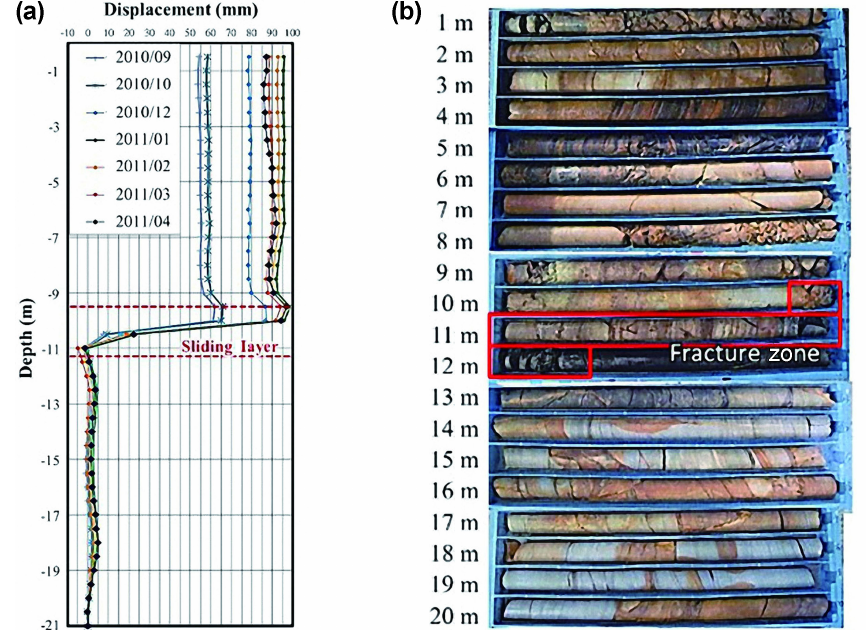
Figure 12. Displacement record (a) and rock core (b) of the inclinometer no. SIS-14. The rock core was collected when the inclinometer hole was